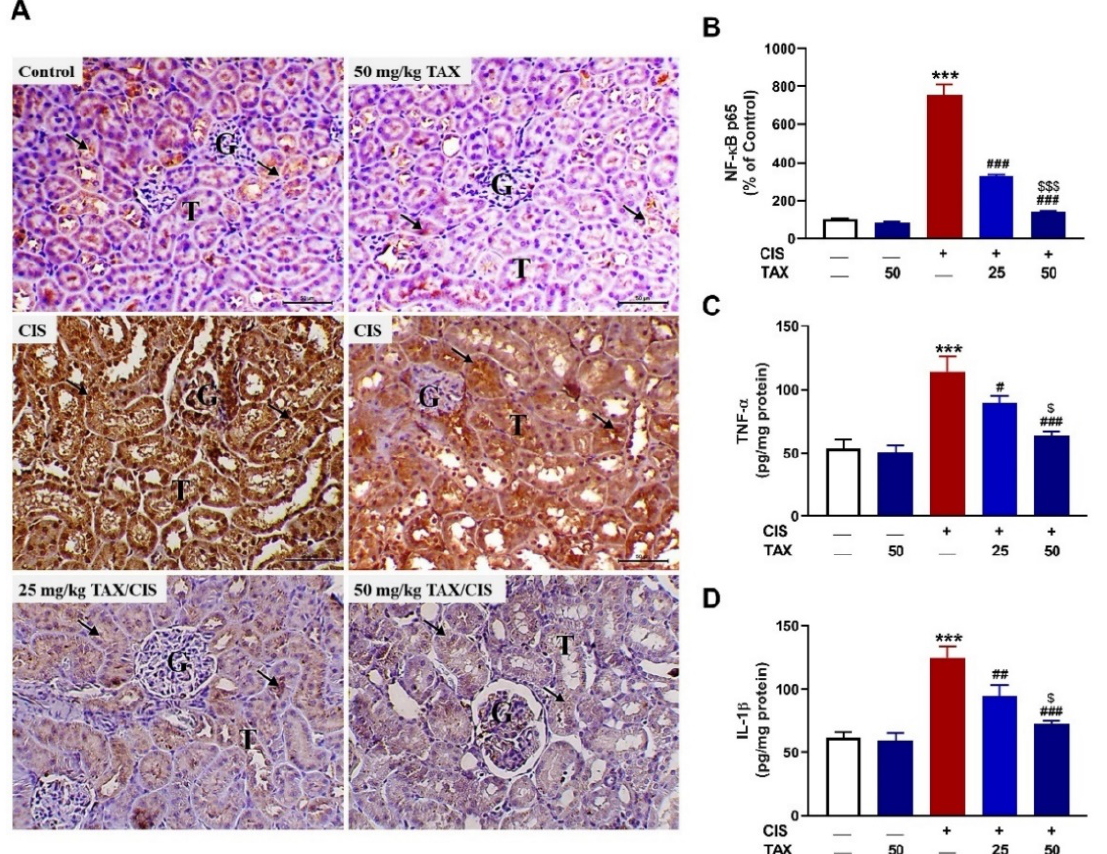
Figure 5. TAX mitigated CIS-induced renal inflammation. ( A ) Photomicrographs of sections in the kidney of control mice showing slight expression of NF- κ B p65 within the renal tubular epithelium (arrows), TAX-treated mice showing minimal expression of NF- κ B p65, CIS-intoxicated mice showing marked expression of NF- κ B p65 (arrows), and CIS-administered mice treated with 25 and 50 mg/kg TAX showing marked decrease in NF- κ B p65 (arrows). (G, glomeruli; T, tubules—scale bar = 50 µ m). ( B ) Image analysis of NF- κ B p65 showing a significant decrease in NF- κ B p65 in CIS-administered mice treated with TAX. (C-D) TAX decreased TNF- α ( C ) and IL-1 β ( D ) in CIS-administered mice. Data are mean ± SEM, ( n = 6). *** p < 0.001 versus Control, # p < 005, ## p < 0.01 and ### p < 0.001 versus CIS, and $ p < 0.05 and $$$ p < 0.001 versus TAX (25 mg/kg).